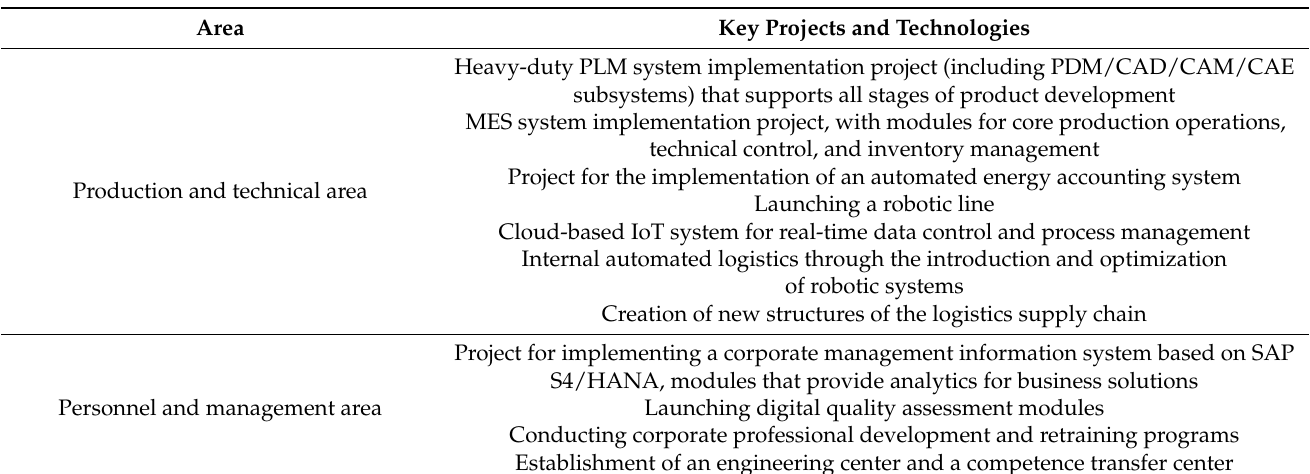
Table 1. Potential directions and projects of digital transformation of an instrumentation enterprise. Area Key Projects and Technologies